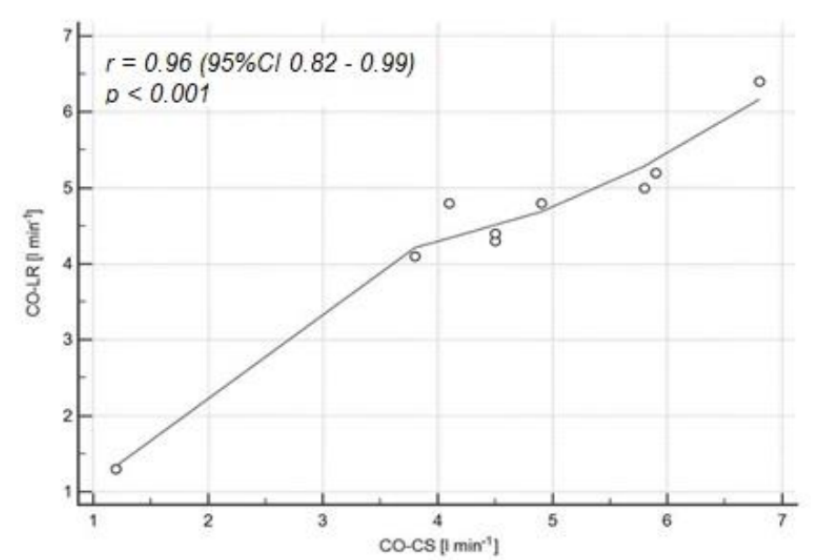
Figure 4. Correlation between the CO-LR and CO-CS values for the recording of the pulse wave curve with a visible dicrotic notch ( n = 9). The solid horizontal line represents the mean value difference between the methods tested. The upper dashed line shows the upper compliance limit value (+1.96 SD). The lower dashed line shows the value of the lower compliance limit ( − 1.96 SD); SD—standard